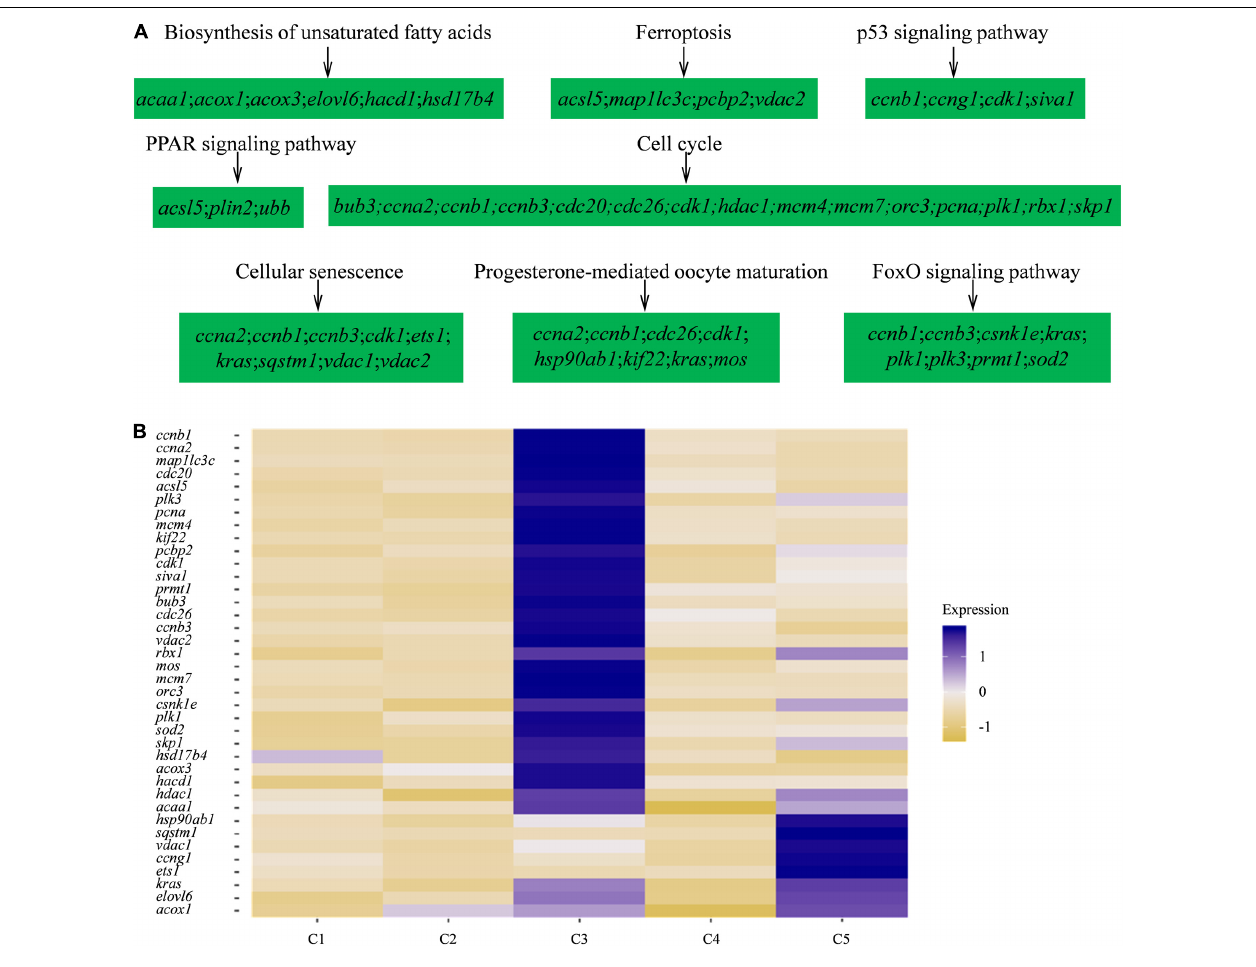
FIGURE 3 | Signaling pathways enriched in five clusters by KEGG analysis. (A) GSEA enrichment plots of KEGG signaling pathways of five clusters. (B) Heatmap of the upregulated genes involved in the eight KEGG pathways.